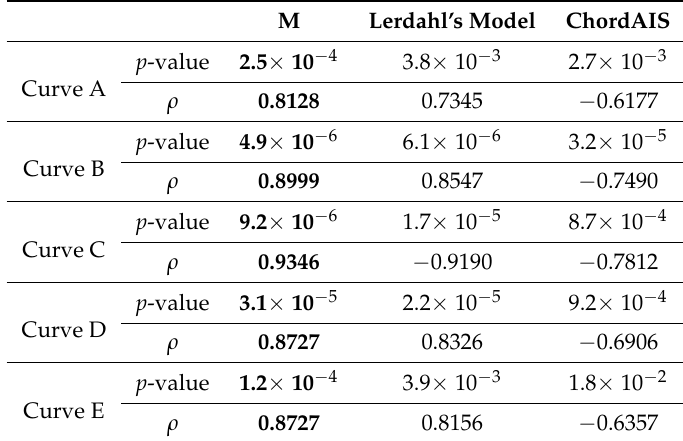
Table 1. Comparison of the statistics resulting from organizing the subjective ratings as a function of measures from other tonal tension